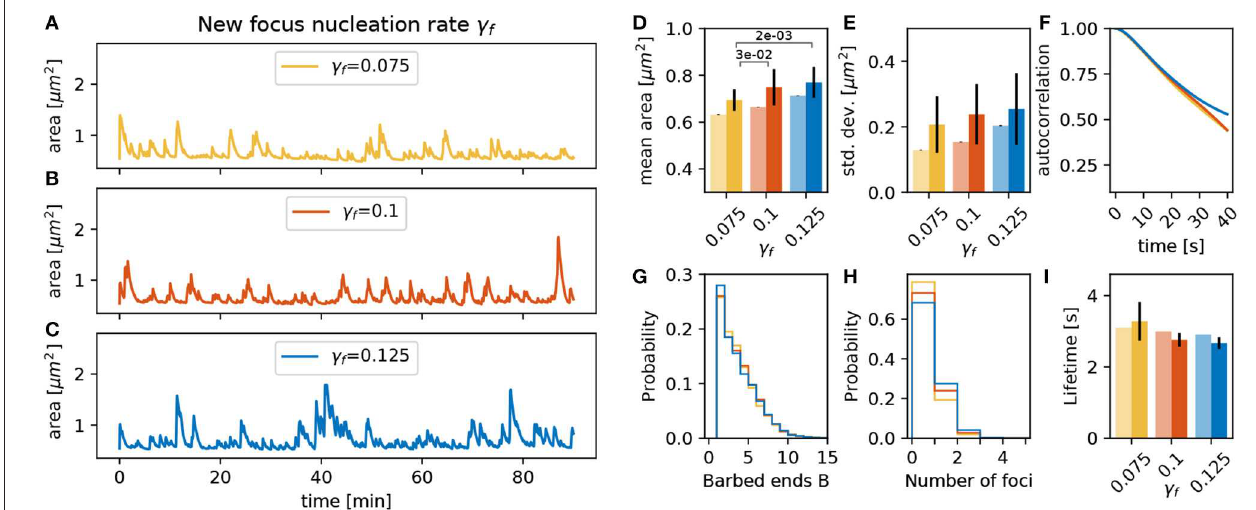
0.075, (B) γ f 0.100, and (C) = =